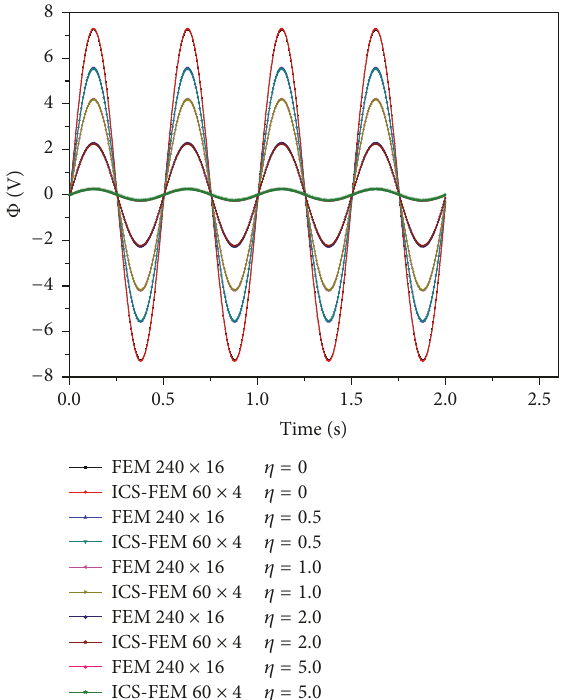
Figure 17: Temporal variations of electric potential Φ at point 𝐴 of BaTiO 3 FGMEE energy harvester with different values of exponential factor calculated by ICS-FEM and